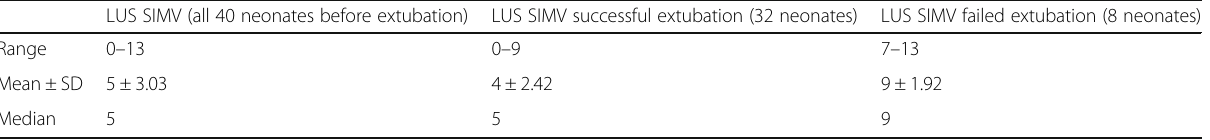
Table 3 Showing LUS scores for neonates on SIMV ventilation before weaning and extubation and the difference in scores between patients with successful and failed